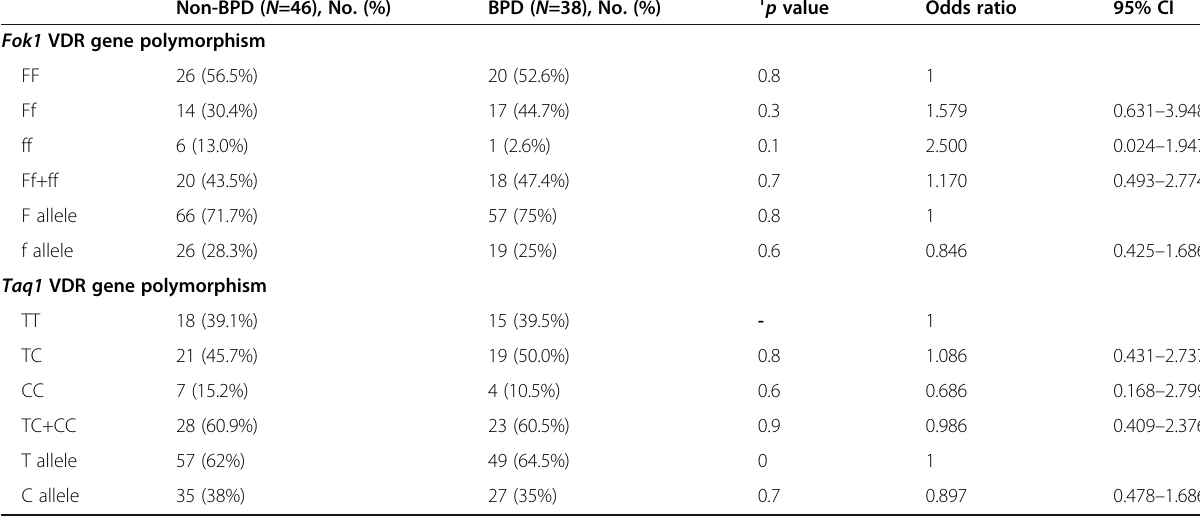
Table 2 Genotypic distribution and allelic frequencies of Taq 1 and Fok 1 VDR polymorphisms Non-BPD ( N =46), No. (%) BPD ( N =38), No.